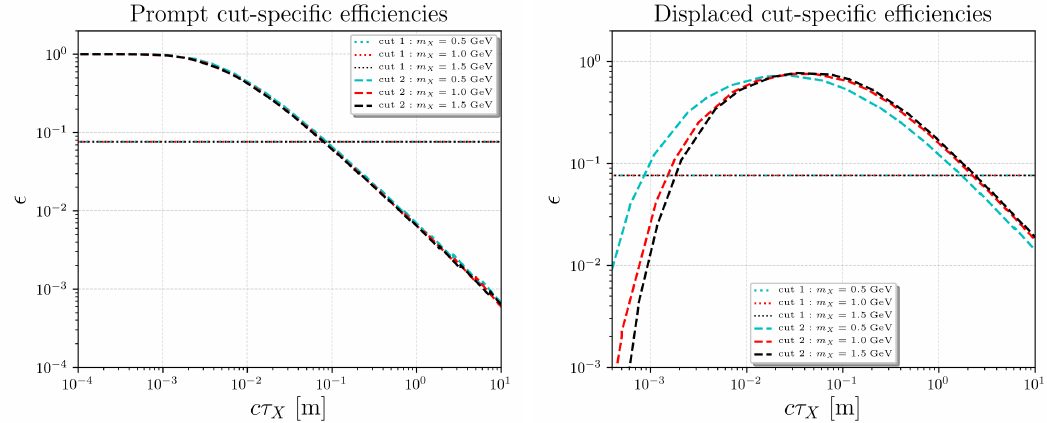
Figure 8 . Efficiencies for Scenario 2 ( g τµ and g µµ are non-zero). The format is the same as in figure 6, except for the different set of mass choices: m X = 0 . 5 , 1.0, and 1.5 GeV.